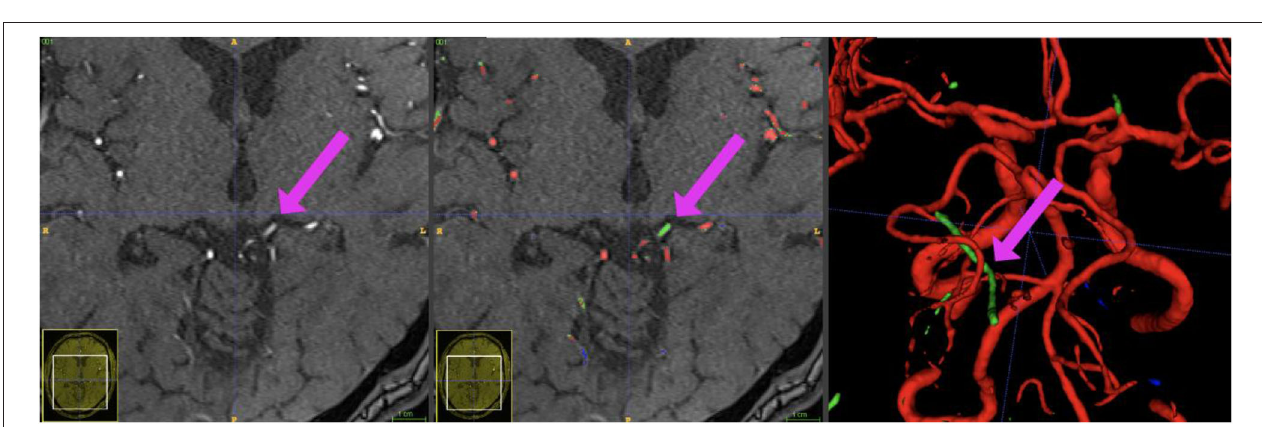
FIGURE 7 | Example patient showing the phenomenon of a hyperintense Vena basalis rosenthali. In some patients, the flow of venous structures feeding the sinus rectus is high enough to be depicted in TOF-imaging. Since these structures are located very centrally in the brain and are very close to arterial structures, none of the presented models was able to correctly ignore these structures in all images. Blue crosshairs depict the same coordinates in all three